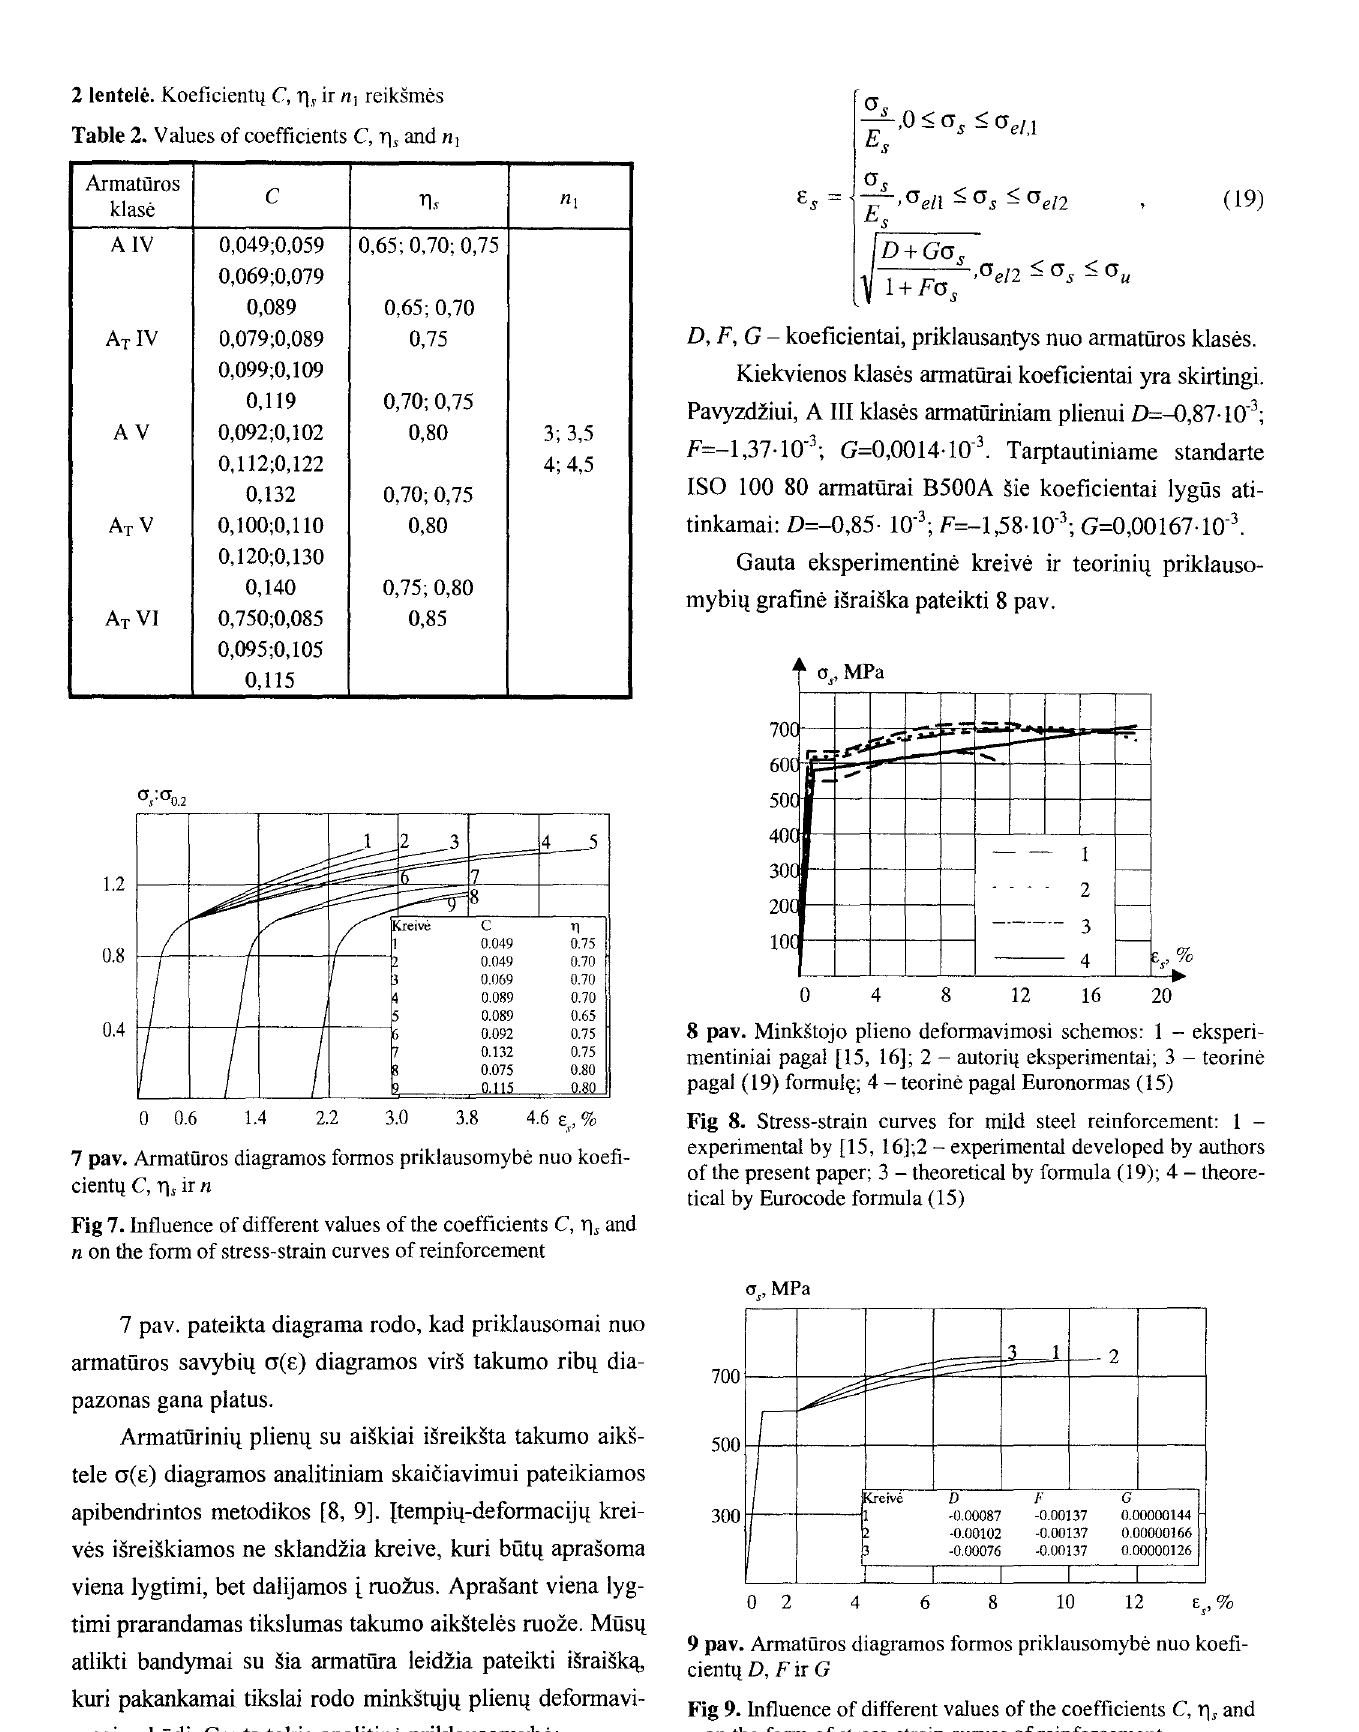
9 pav. Armatilros diagramos formos priklausomybe nuo koefi Fig 9. Influence of different values of the coefficients C, T], and n on the form of stress-strain curves of